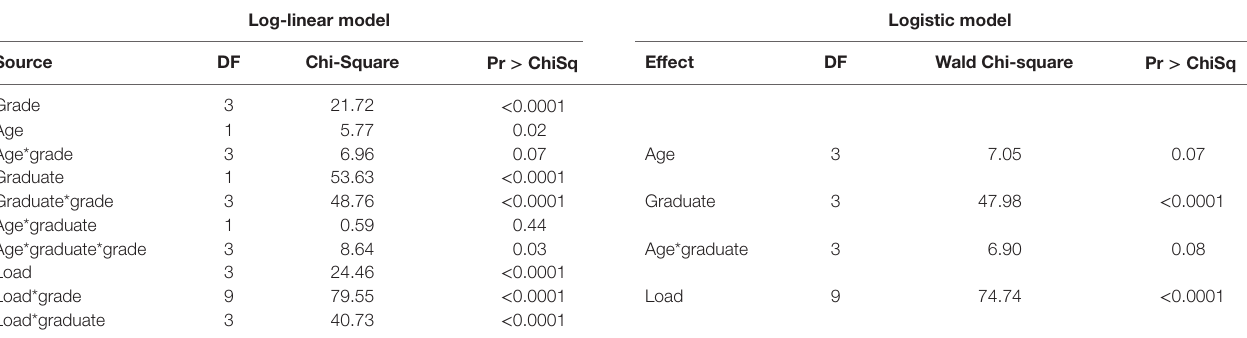
TABLe 9 | Comparison of the estimates from log-linear and logistic models. Log-linear model Logistic model